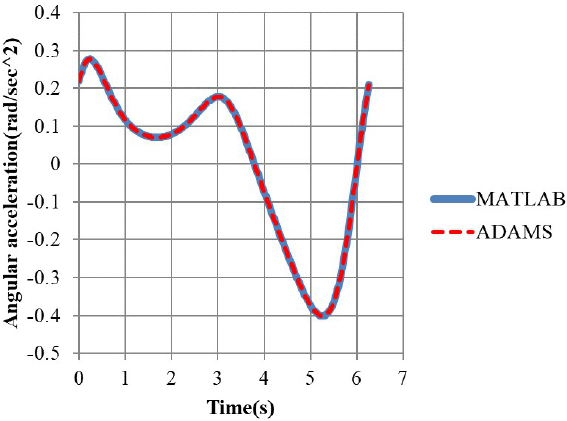
Figure 10. Comparison of our modeling computation with that of ADAMS on α 3 . Figure 10. C omparison of our modeling computation with that of ADAMS on